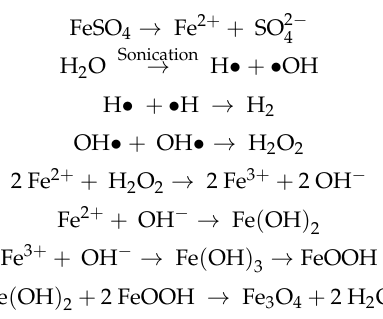
Table 2. Formation of iron oxide nanoparticles through